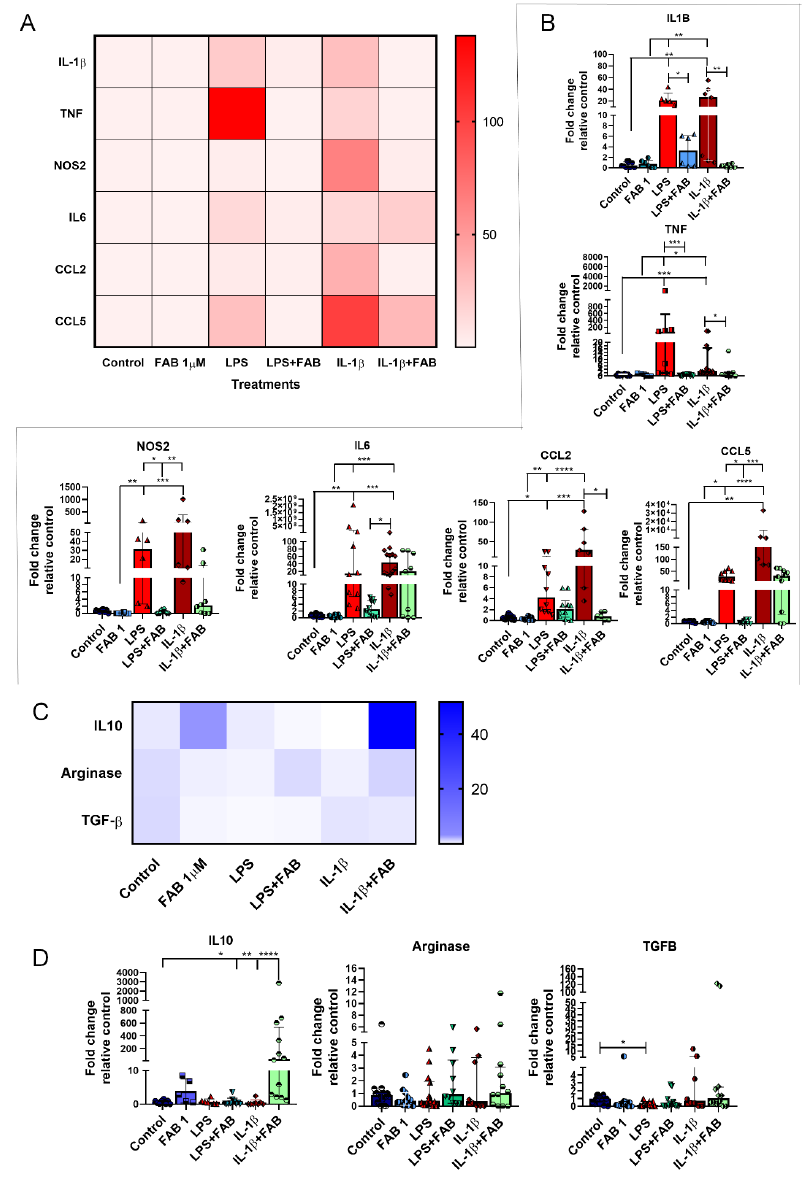
Figure 7. RT-qPCR of key inflammatory genes in neuron–glial cocultures exposed to LPS- or IL-1 β -induced damage and treated with 1 µM FAB. ( A ) Heat map of inflammatory genes showed an important effect against proinflammatory molecules commonly implicated in most neurodegenerative diseases. ( B ) Scatter dot plot bar graphs showing quantitative data obtained from real-time qPCR of the proinflammatory genes shown on heat map; values are expressed as mean ± SEM or median ± interquatile range (IQR), and samples with Gaussian distribution were analyzed by one-way ANOVA followed by Tukey’s post hoc test, while nonparametric samples (scatter plot graph) were analyzed by the Kruskal–Wallis test followed by Dunn’s test. ( C ) Heat map of genes involved in the control of inflammation. ( D ) Scatter dot plot bar graphs show the expression of anti-inflammatory genes and respective di ff erences among the treatments; values are expressed as the median ± IQR. Significant di ff erences are indicated with * p < 0.05, ** p < 0.01, *** p < 0.001, and **** p <